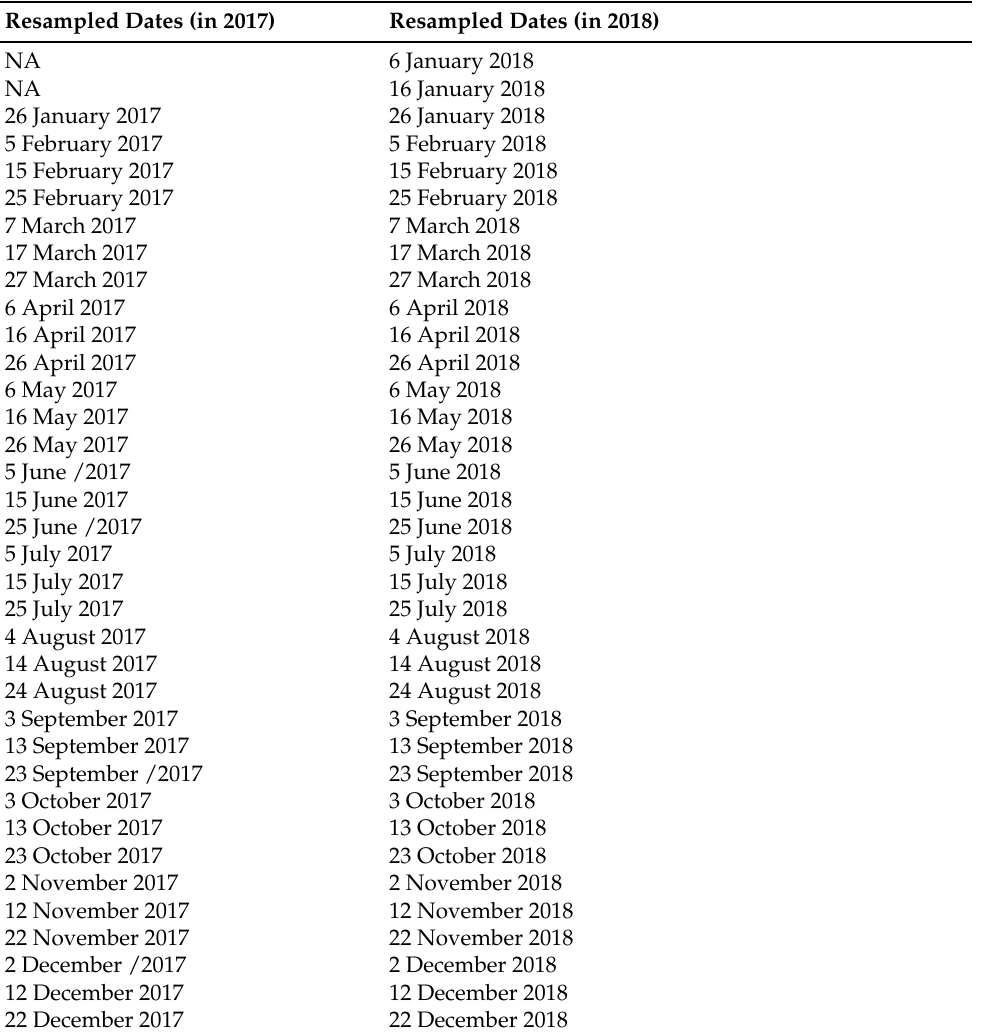
Table A1. Common resampled dates over 2017 and 2018 time